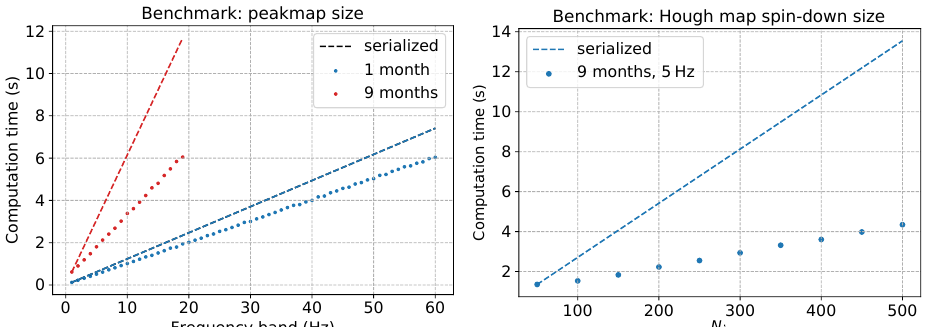
Figure 8. GPU tests for the FrequencyHough algorithm on a Tesla k20 (2496 cores at 706 MHz and 5 GB of memory) changing some key parameters: the size of the input (time interval–frequency range of the peakmap), and the size of the parameter space (number of spindown bins). The plots show the increasing efficiency of the GPU parallelism with a higher load on the memory and cores of the device. Left: computation time as a function of the frequency band covered by the peakmap. The measured computation times (dotted lines) are compared to those we would obtain by serializing the GPU code over 1 Hz peakmaps (dashed lines). The red plots show that, with a 20 Hz large peakmap, when the memory of the device is full, the efficiency of the parallelization halves the computation time needed for a separate analysis of 20 1 Hz large peakmaps. The blue plot comes from a 1 month long peakmap, with a 20% time gain. Right: computation time as function of the number of spindown steps of the Hough map, with T obs = 9 months and ∆ f = 5 Hz. Dotted and dashed lines have the same meaning as before. The plot shows a 68% time reduction with respect to the serialized case, proving that the vectorization with TensorFlow is